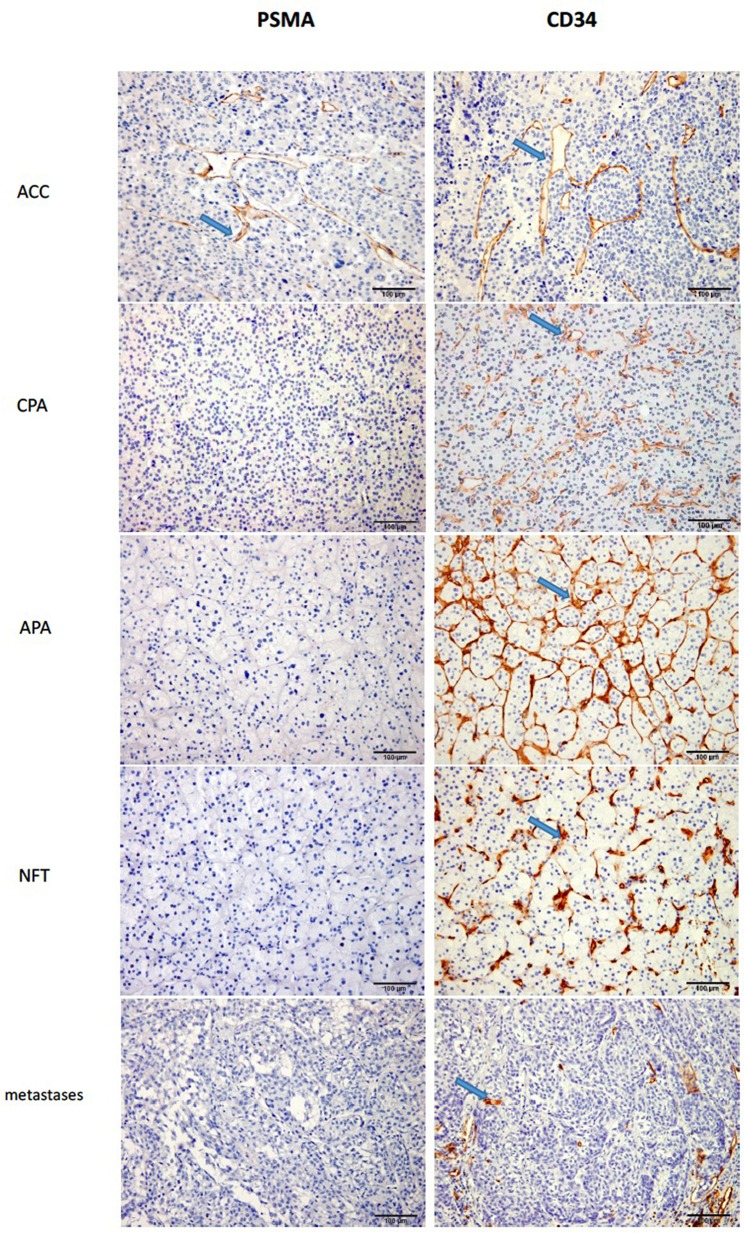
The staining of PSMA and CD34 in ACA and ACC (X200). As we can see from the figure, the staining of PSMA in CPA, APA, NFT and metastases were negative, while in ACC it was positive with high percentage.